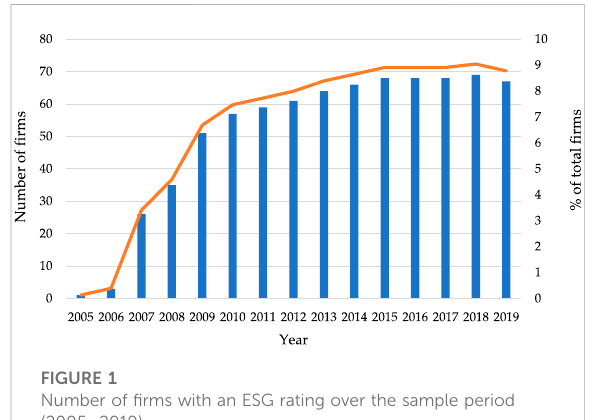
FIGURE 1 Number of fi rms with an ESG rating over the sample period (2005 –